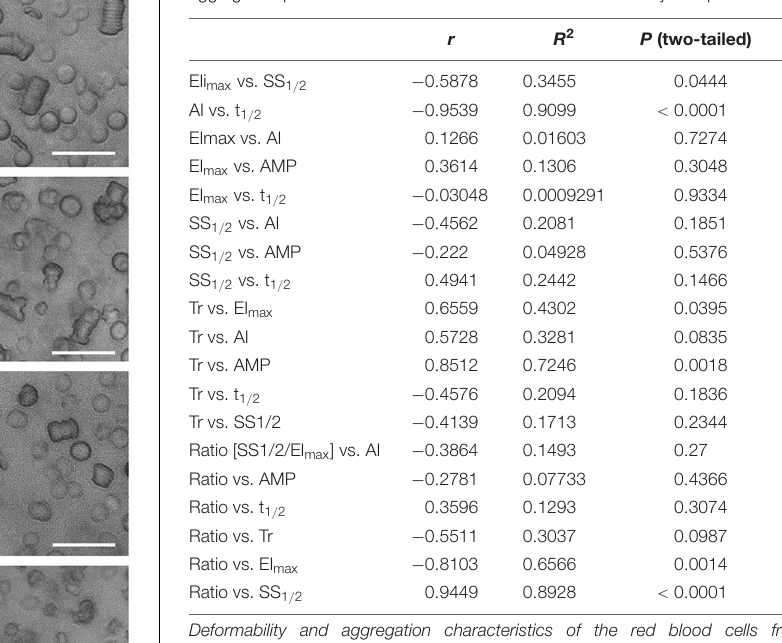
TABLE 2 | Determination of the correlations between deformability and aggregation parameters of red blood cells from neuroacanthocytosis